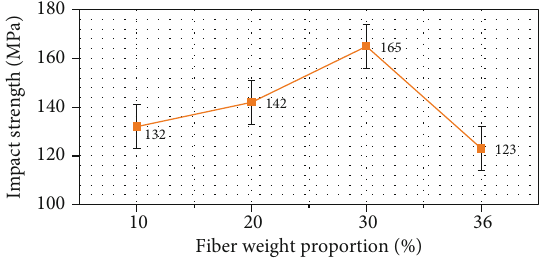
Figure 10: E ff ect of fi ber weight proportion on impact strength.